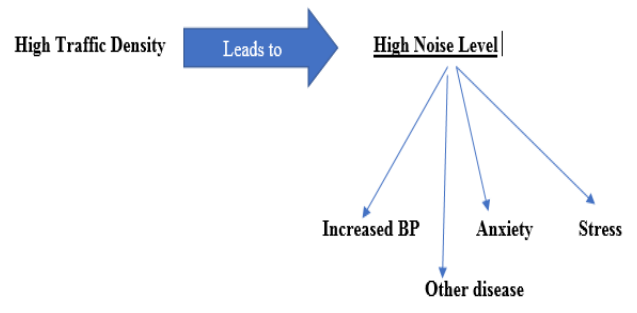
Figure 7: Effects of noise pollution